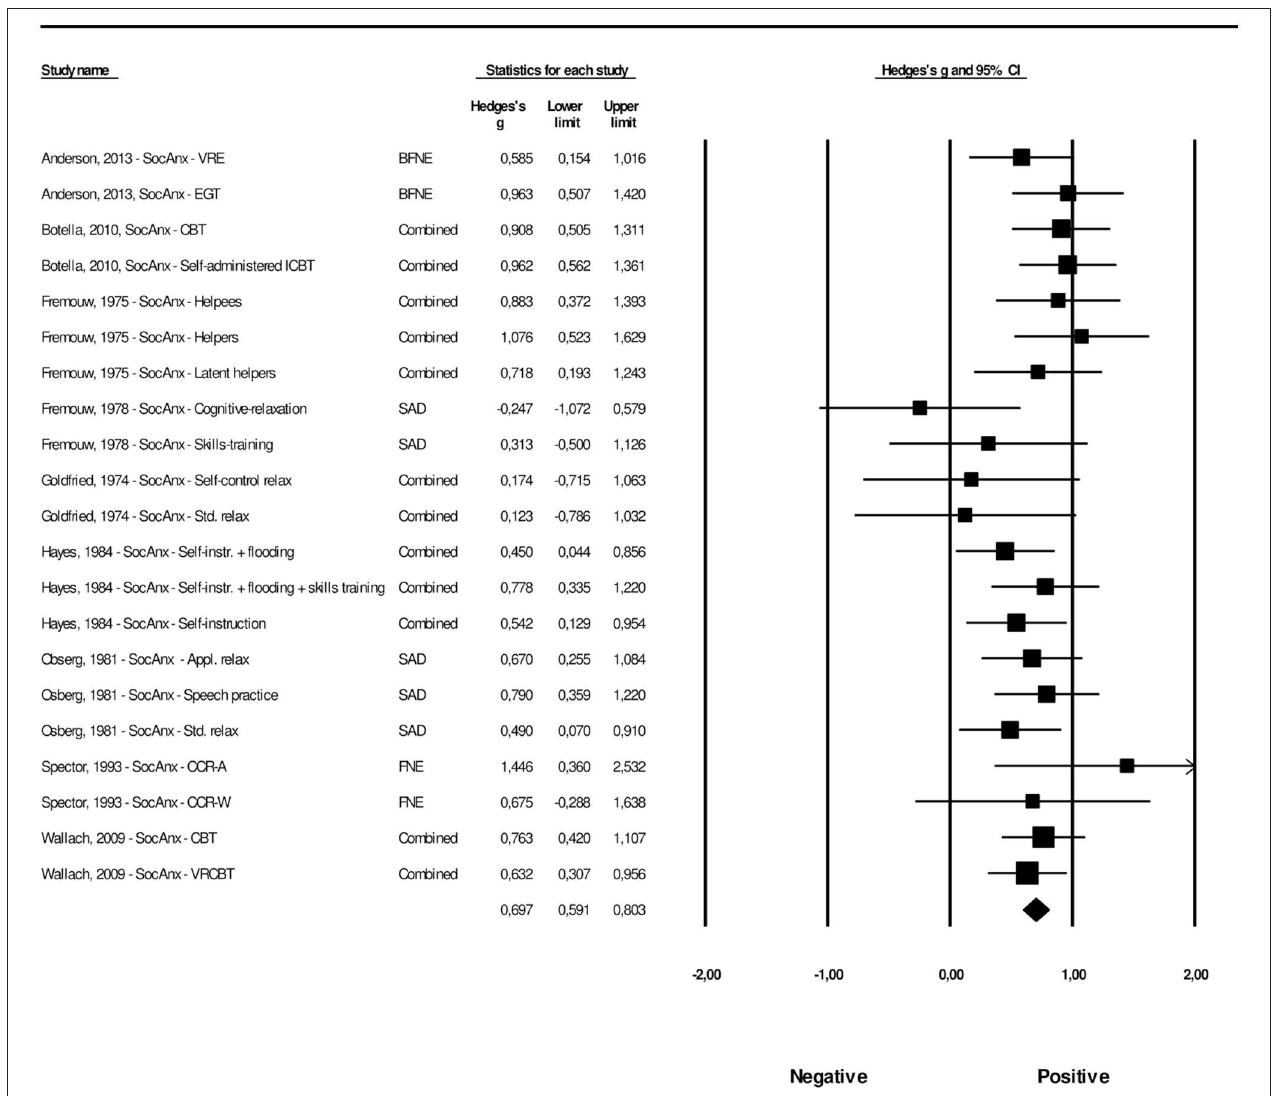
FIGURE 6 | A forest plot of the standardized effect sizes of psychological treatments aimed at fear of public speaking on generalized social anxiety at